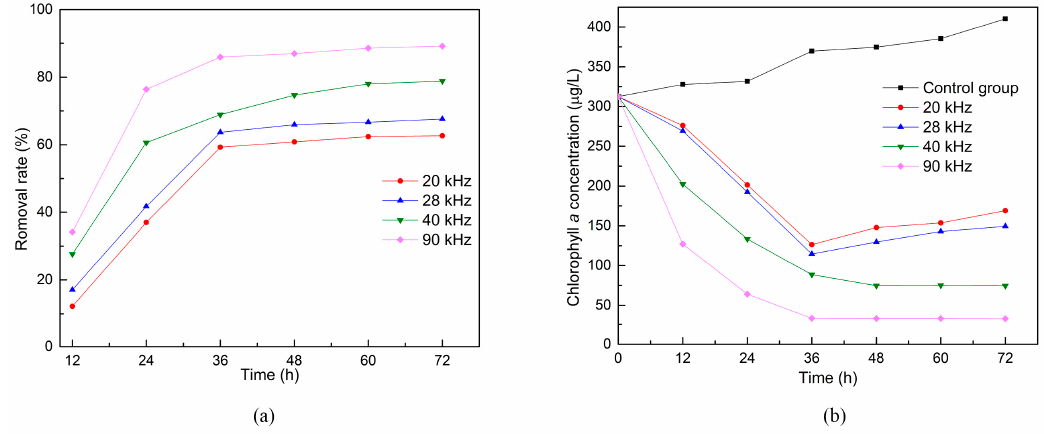
Figure 3. ( a ) Algae removal rate and ( b ) concentration of chlorophyll a after treatment for 5 min at different ultrasonic frequencies.